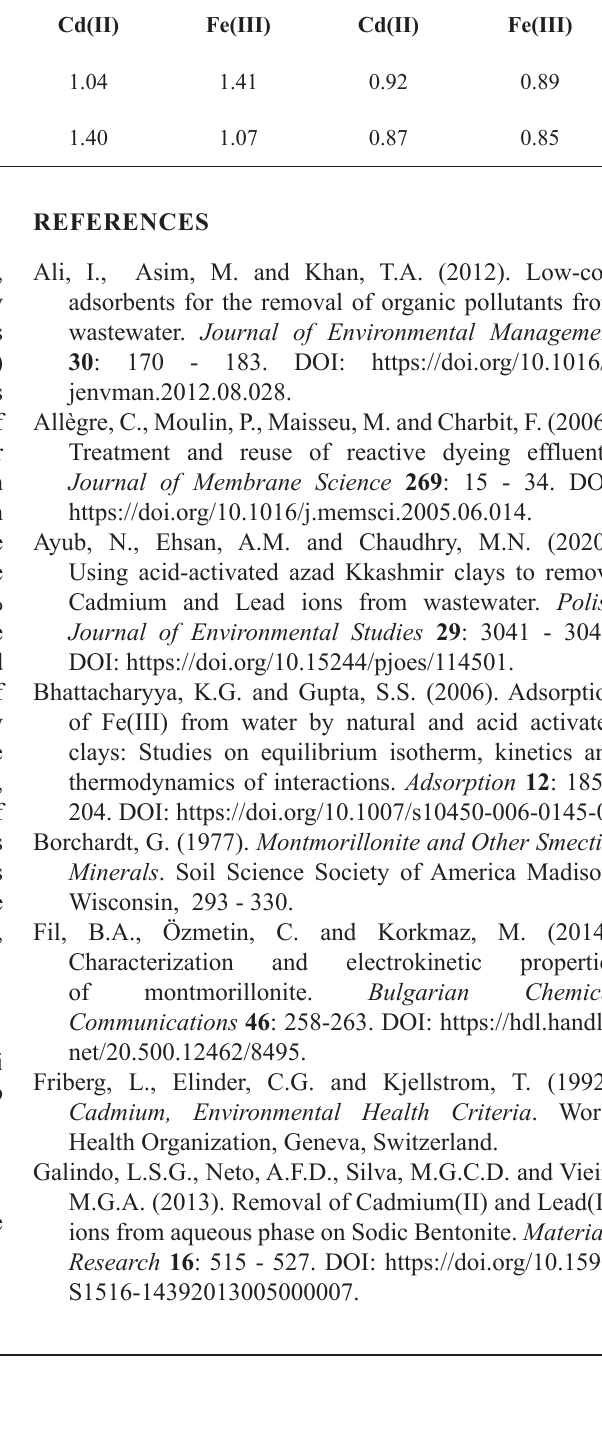
Table 4: Freundlich adsorption isotherm constant for Cd(II) and Fe(III) ions. Adsorbent